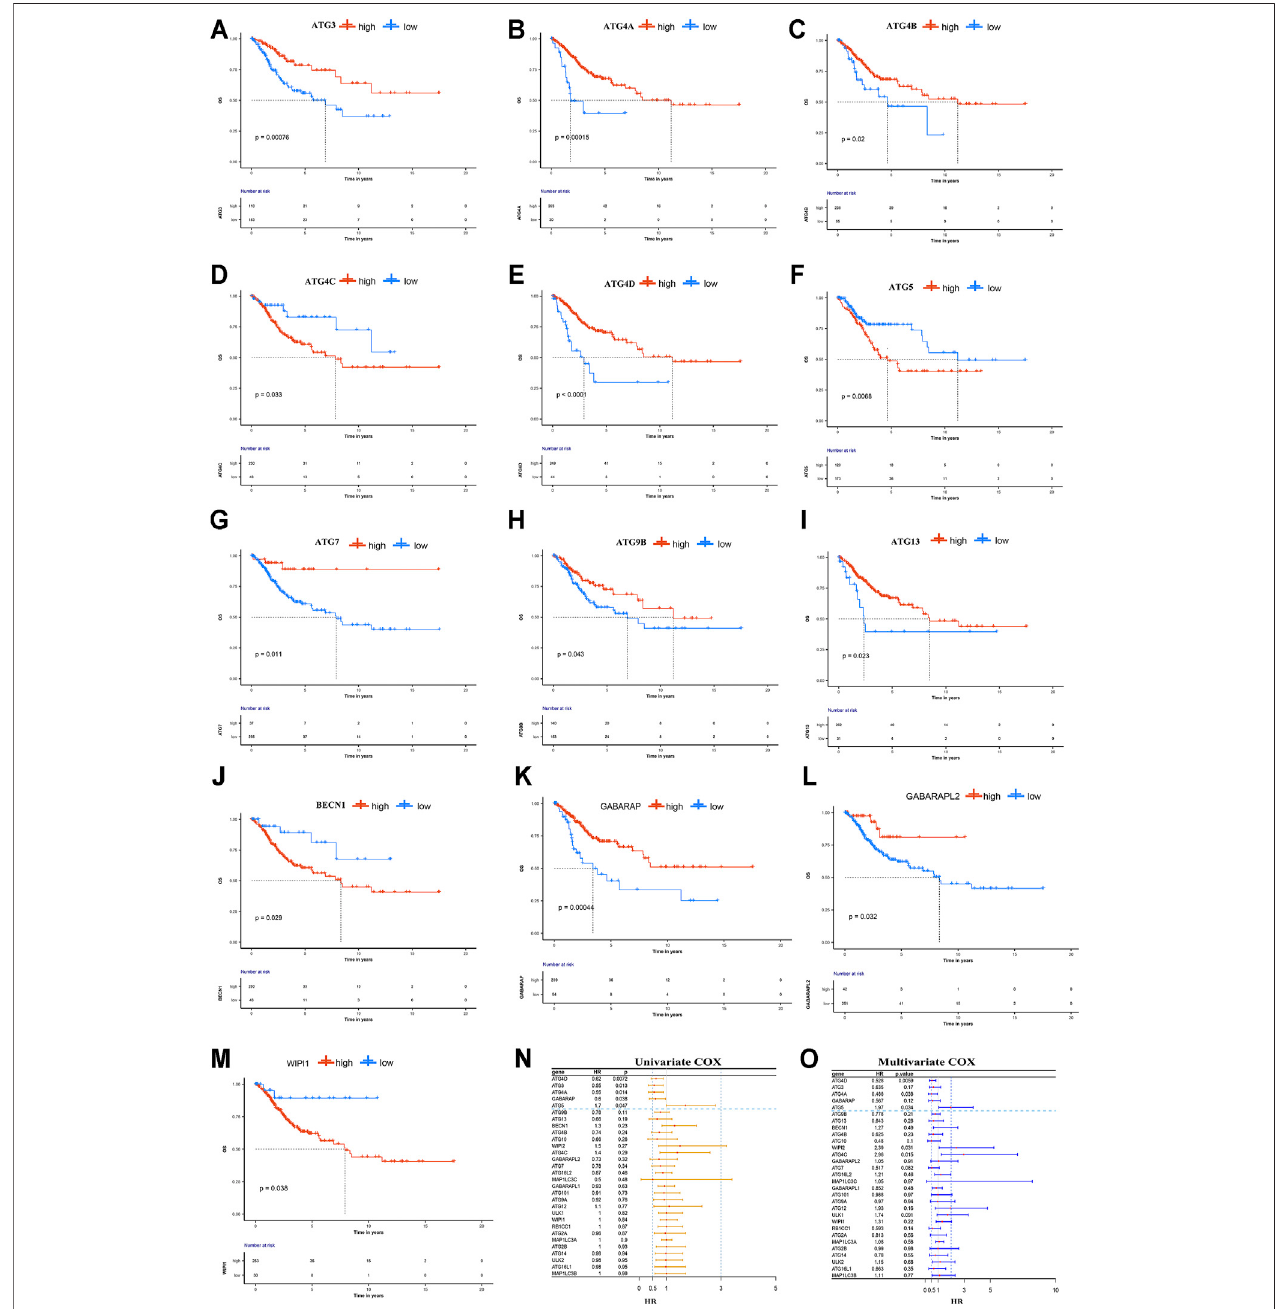
FIGURE1| Overallsurvivalanalysison ARGsincervicalcancer.Theexpression of (A) ATG3 (B) ATG4A (C) ATG4B (E) ATG4D(G)ATG7 (H) ATG9B (I) ATG13 (K) GABARAP, and (L) GABARAPL2 were associated positively with OS, while increased expression of (D) ATG4C (F) ATG5 (J) BECN1, and (M) WIPI1 negatively correlatedwith OS.Figure (N, O) According totheforestplotforthe Univariate and Multivariate Cox regression analysisresults, ATG5wasariskprognostic factor, while ATG4D, GABARAP, ATG4A, and ATG3 were favorable prognostic factors in CESC patients. And, ATG5, ATG4D, and ATG4A were independent prognostic